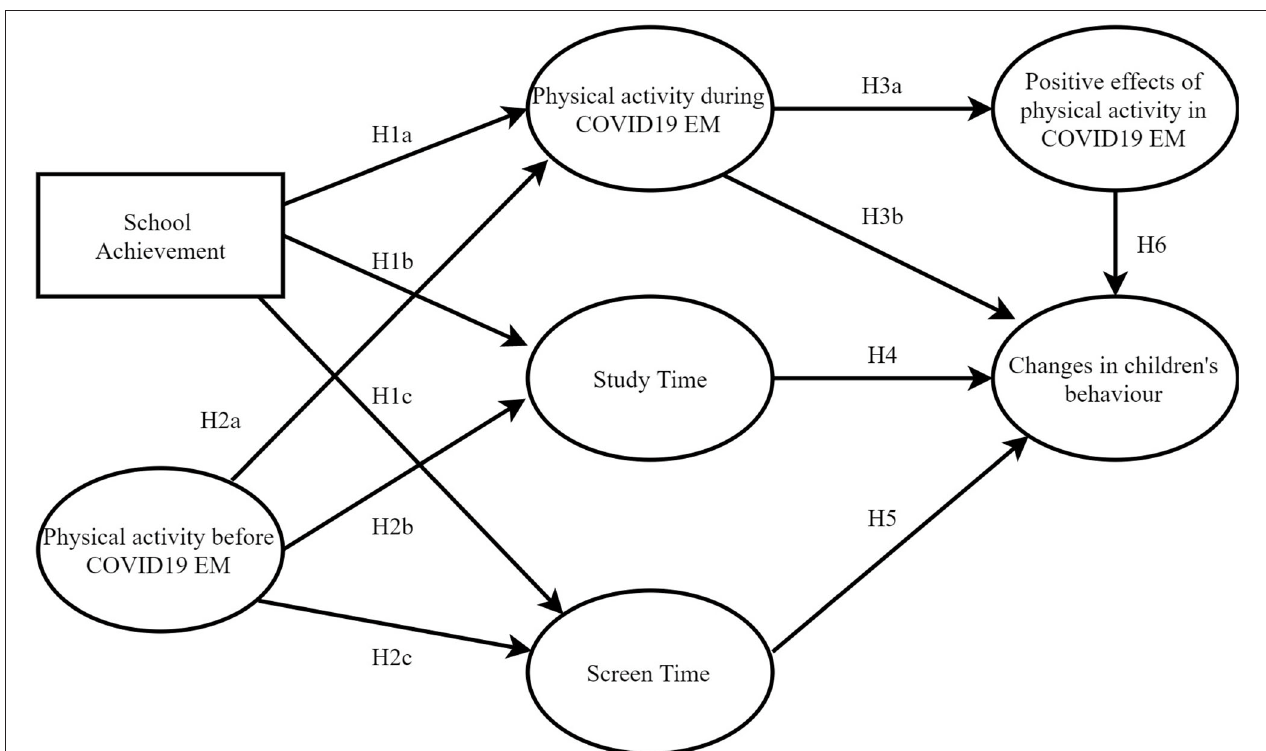
FIGURE 1 | Proposed hypothesized